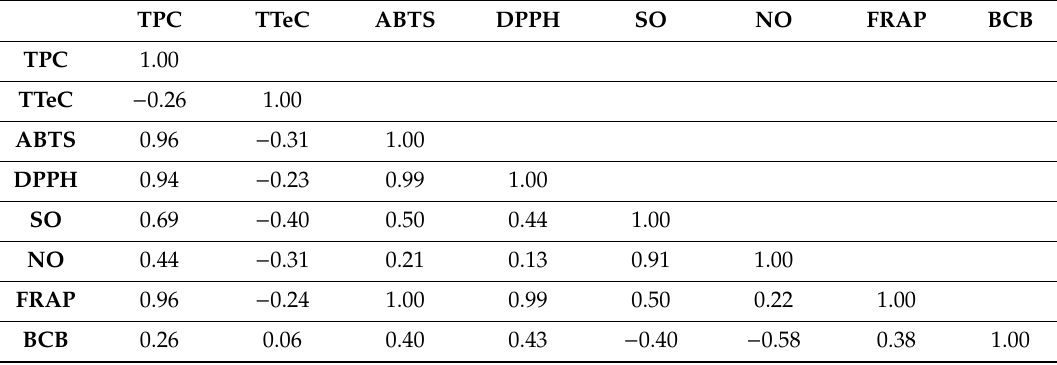
Table 2. Pearson correlation coe ffi cient calculated among tested M. di ff usa samples.